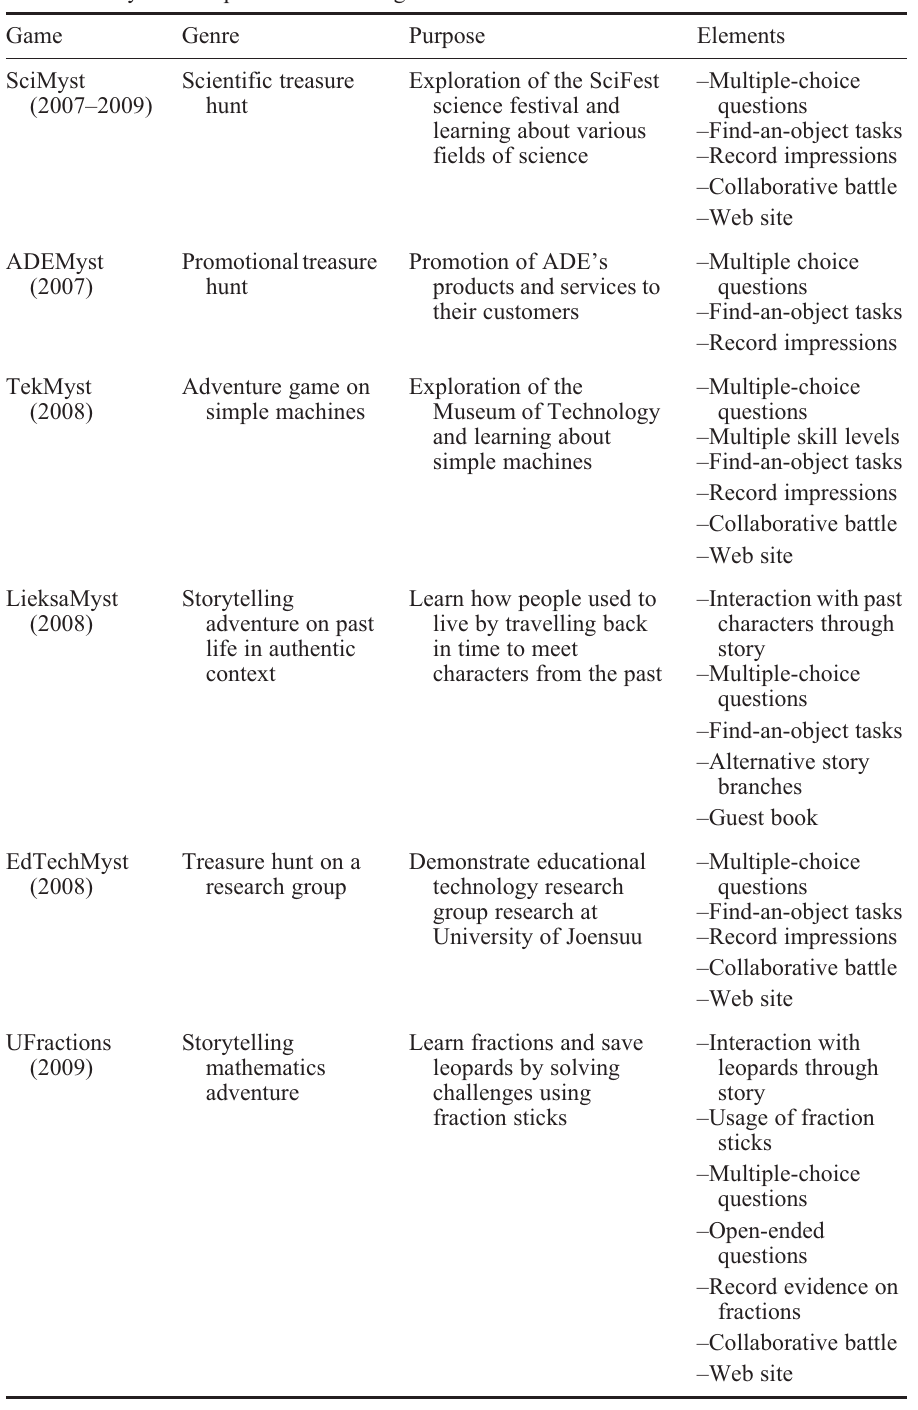
Table 1. Myst-based pervasive mobile